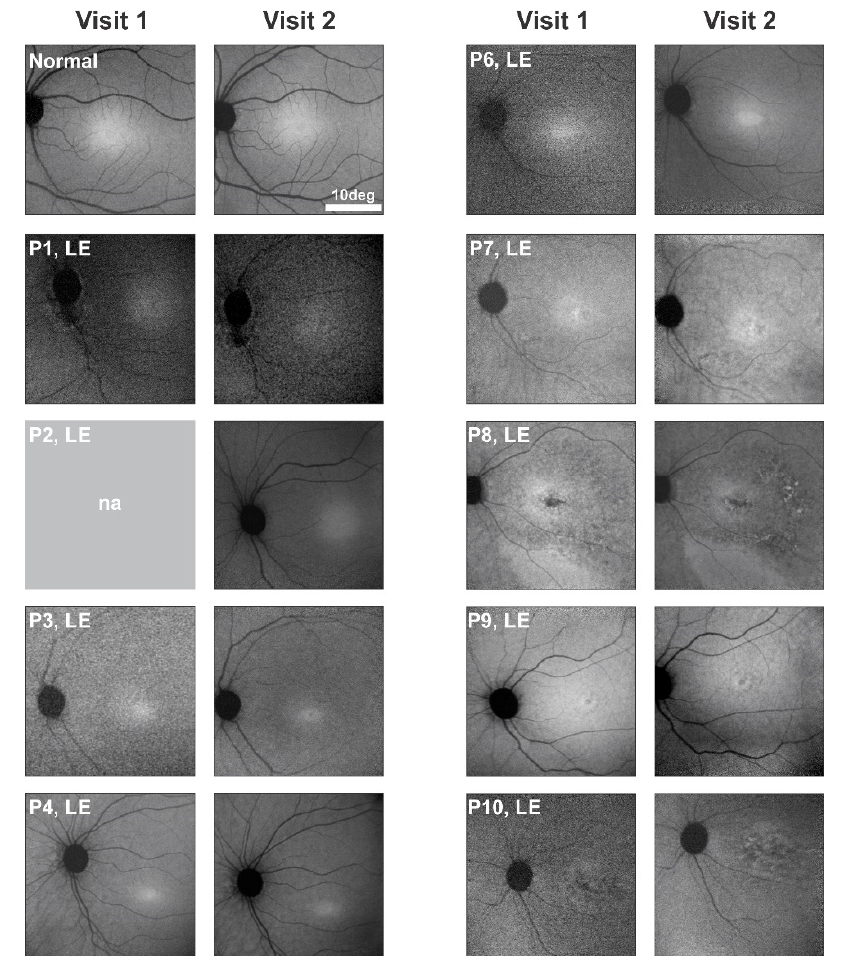
Figure 1. En face near-infrared reduced illuminance autofluorescence (NIR-RAFI) images from the left eye of nine GUCY2D -LCA patients at two visits. Also shown are images of a normal eye acquired at ages 7 and 14 years. Images from Visit 1 of P2 and both visits of P5 were not available. The images from P1–P4 and P6 are within normal limits, and there is no obvious change on the second visit. Retinal pigment epithelium (RPE) abnormalities are present in the macula in P7, P8, P9, and P10 at Visit 1; no notable changes in appearance are evident in the images at Visit 2.